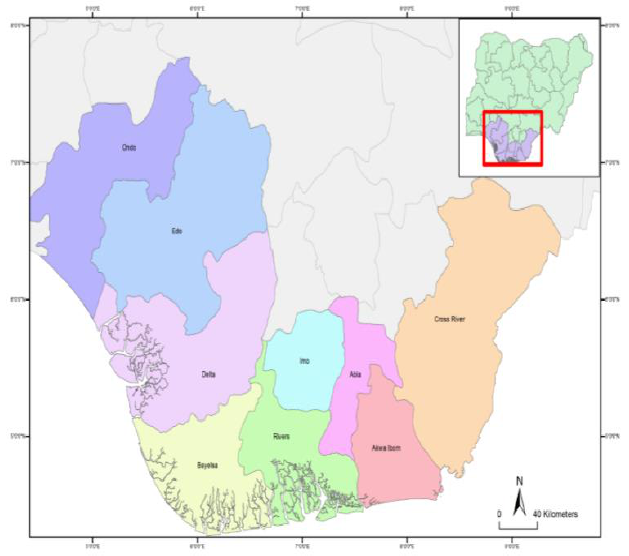
Figure 1: Map of Nigeria showing the nine states of the Niger Delta (Okonkwo et al.,